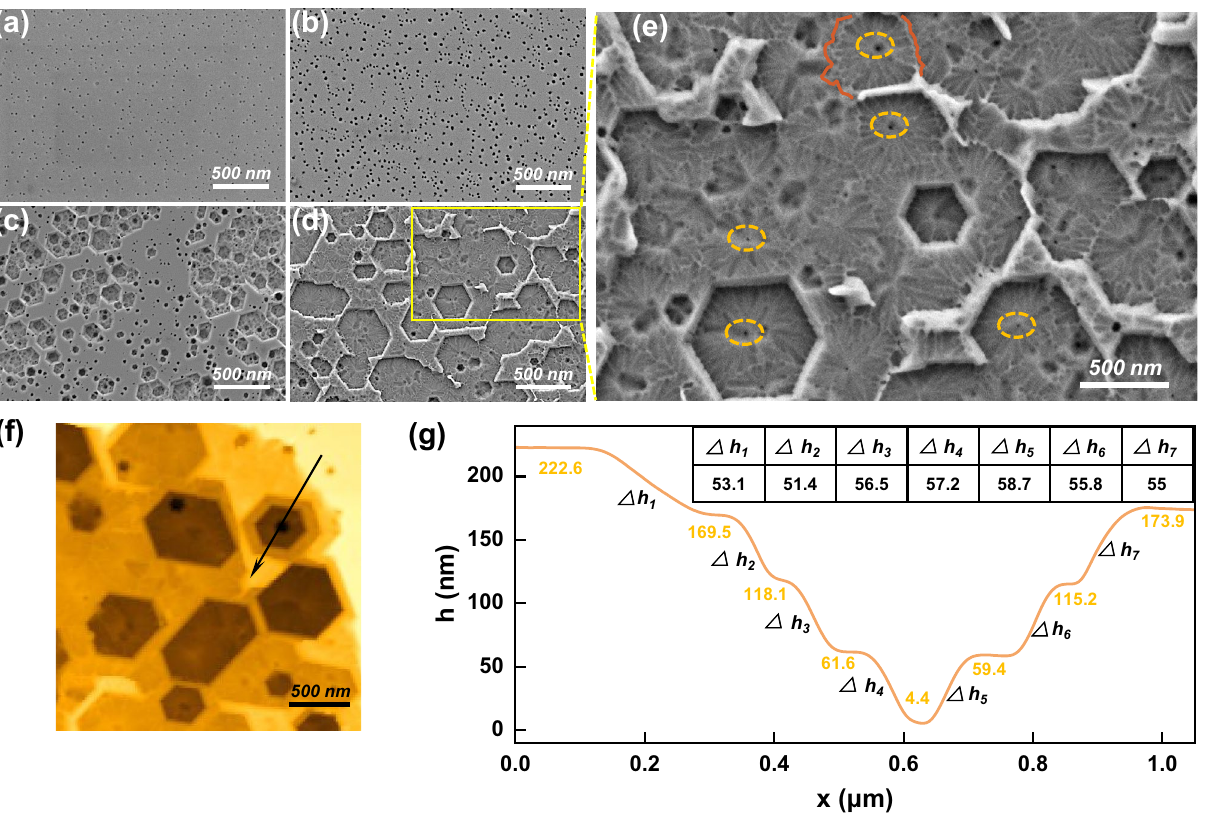
Figure 4. Surface SEM images of the DBR fabricated at 25 V in KOH solution at ( a ) 25 °C, ( b ) 45 °C, ( c ) 65 °C and ( d ) 85 °C; ( e ) Enlarged surface SEM image and ( f ) AFM of DBR fabricated at 25 V and 85 °C; ( g ) Depth profile of the hexagonal pit marked in ( f